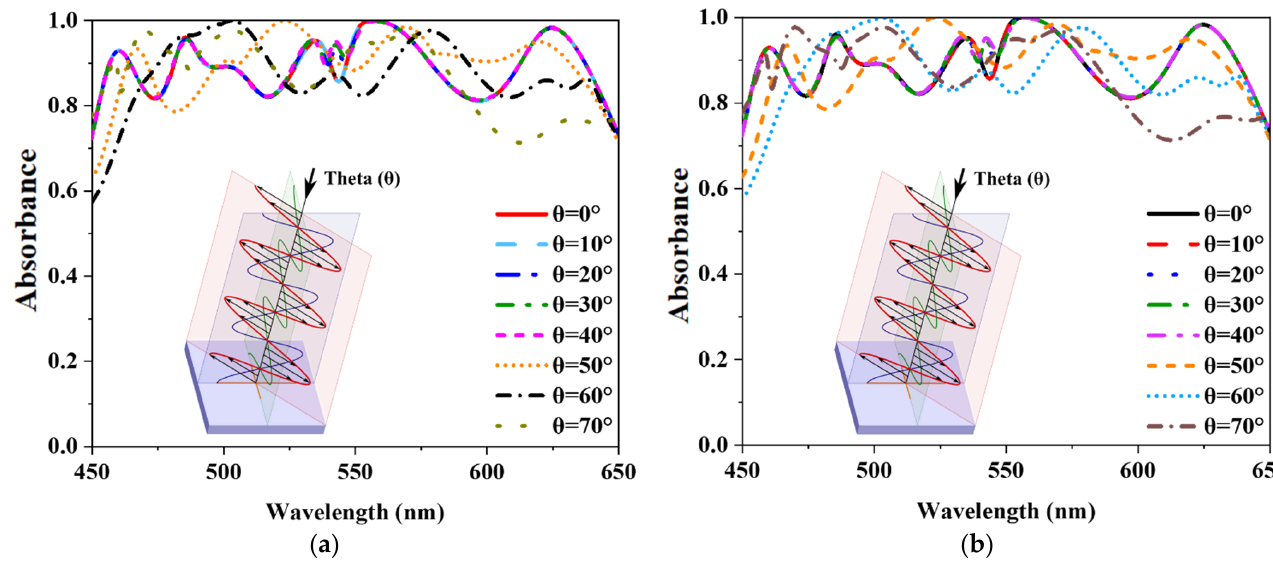
Figure 11. Angular stability characteristics of the absorber ( a ) TE mode ( b ) TM mode.